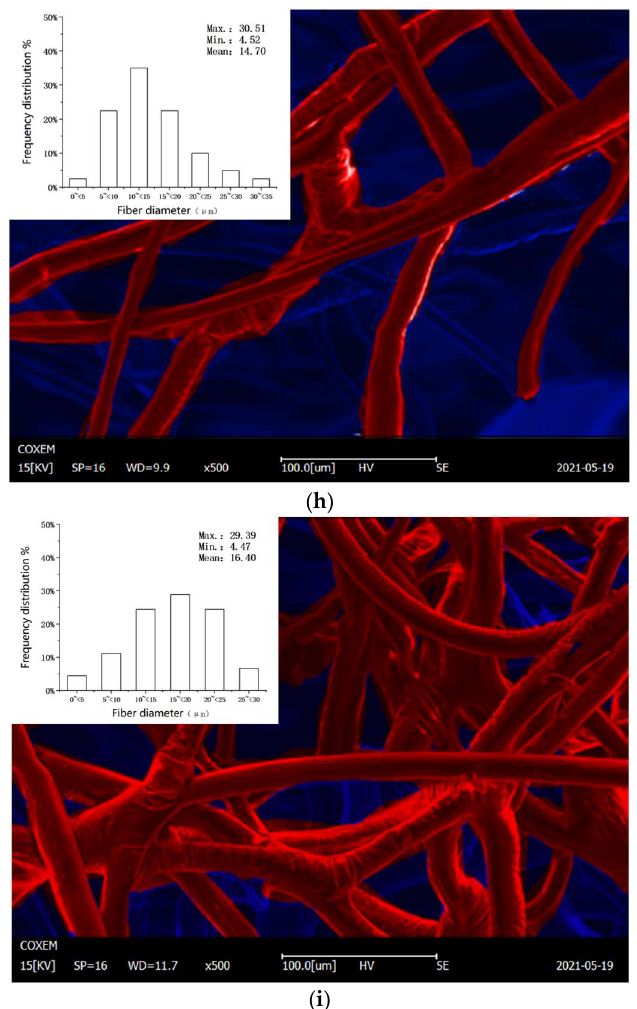
Figure 10. The SEM images of the ( a ) untreated 3M KN95 respirator, ( b ) 3M KN95 respirator at 80 °C for 24 h, ( c ) 3M KN95 respirator at 90 °C for 24 h, ( d ) untreated CM 8228-1 KN95 respirator, ( e ) for 24 h, ( c ) 3M KN95 respirator at 90 ◦ C for 24 h, ( d ) untreated CM 8228-1 KN95 respirator, ( e ) CM CM 8228-1 KN95 respirator at 80 °C for 24 h, ( f ) CM 8228-1 KN95 respirator at 90 °C for 24 h, ( g ) 8228-1 KN95 respirator at 80 ◦ C for 24 h, ( f ) CM 8228-1 KN95 respirator at 90 ◦ C for 24 h, ( g ) untreated untreated of CM 6002A KN95 respirator, ( h ) CM 6002A KN95 respirator at 80 °C for 24 h, and ( i ) of CM 6002A KN95 respirator, ( h ) CM 6002A KN95 respirator at 80 ◦ C for 24 h, and ( i ) CM 6002A CM 6002A KN95 respirator at 90 °C for 24 h. The upper left graphs are the fiber diameter distribution KN95 respirator at 90 ◦ C for 24 h. The upper left graphs are the fiber diameter distribution histogram.